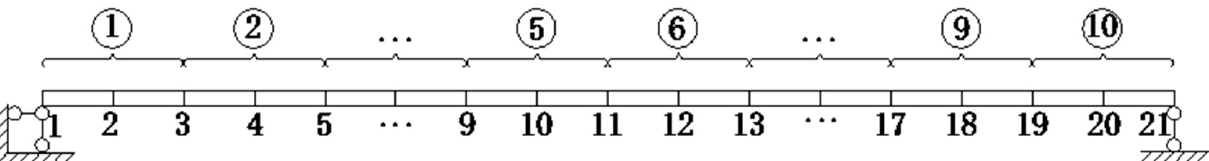
Figure 2. Relative sensitivity of first fourth-order frequencies with virtual mass in substructure 5. Impulse excitation was applied to the original structure with an action time of 2 s and a sampling frequency of 10,000 Hz to determine the acceleration response of the original structure and virtual structures. The acceleration response signal was preprocessed using an exponential window function. Based on Equation (2), the frequency-domain responses of the original and virtual structures, adding a virtual mass on substructure 5, were deter- mined (Figure 3).